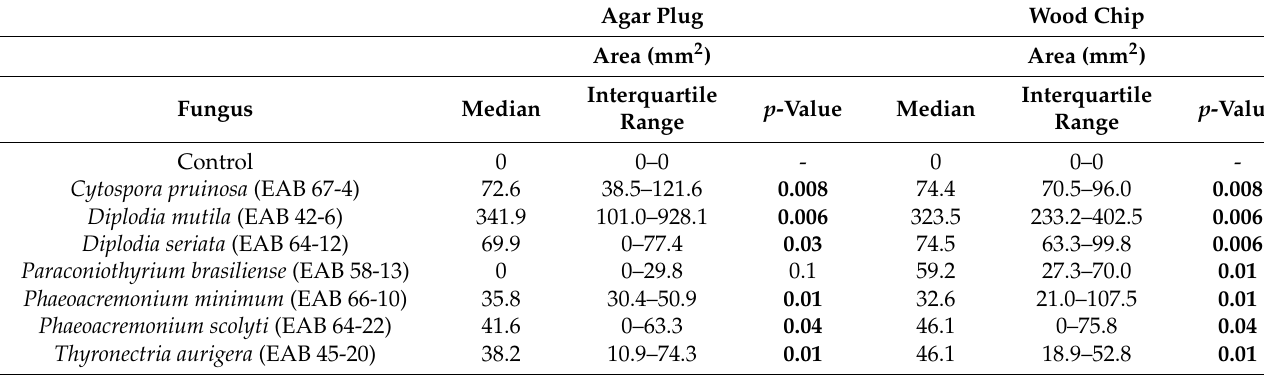
Table 4. Experiment 2 median canker area (mm 2 ) by treatment type and fungus. p -values were calculated by using the Wilcoxon Rank Sum test. Treatments are being compared to the controls in each experiment. Significant results are shown in